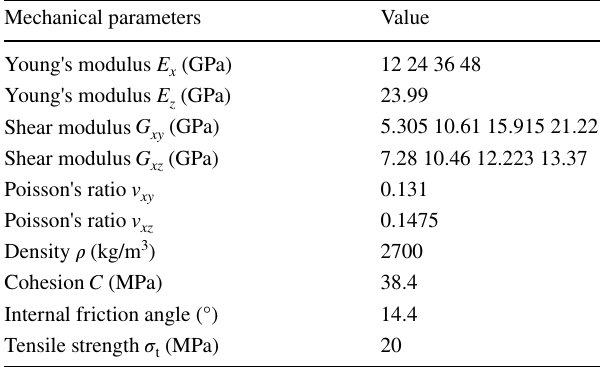
Table 3 Transversely isotropic constitutive parameters for shale Mechanical